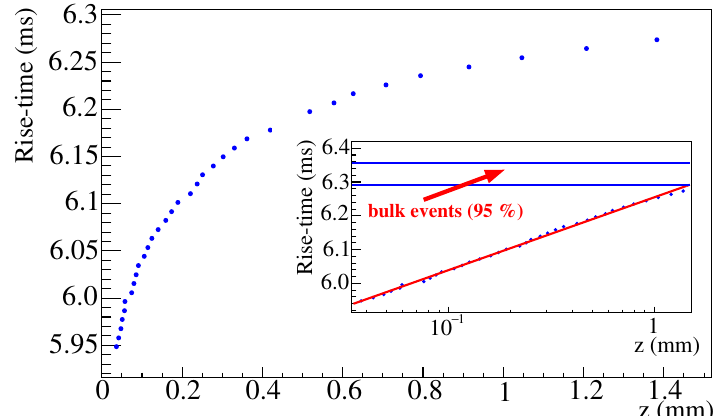
Figure 11 . Pulse rise-time as a function of the depth of the neutron impact point for data collected with Detector 1 of table 1. In the inset, the same relationship in semi-log scale. The band containing 95% of the bulk events is also shown. With the current rise-time resolution, surface events can